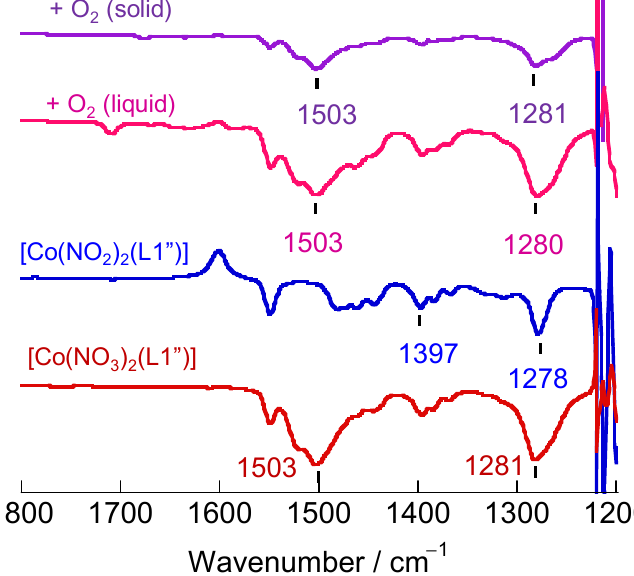
Figure 5. IR spectral comparisons with dioxygen reaction products of [Co(NO) 2 (L1”)](BF 4 ) (solid and solution) and the authentic complexes ([Co( κ 2 -O 2 NO) 2 (L1”)] and [Co( κ 2 -O 2 N) 2 (L1”)]) measured by CH 2 Br 2 solution.